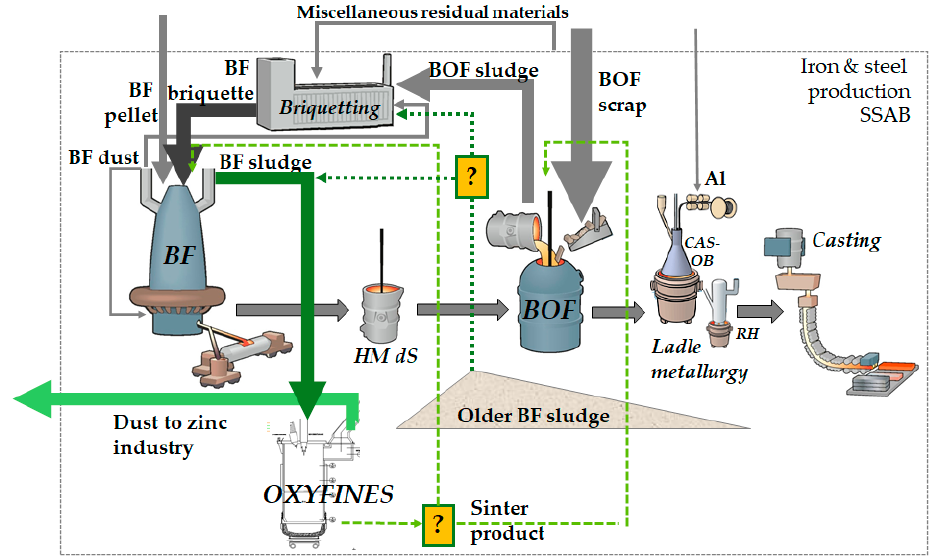
Figure 1. Schematics of the production system, and main zinc flow, including the OXYFINES concept.